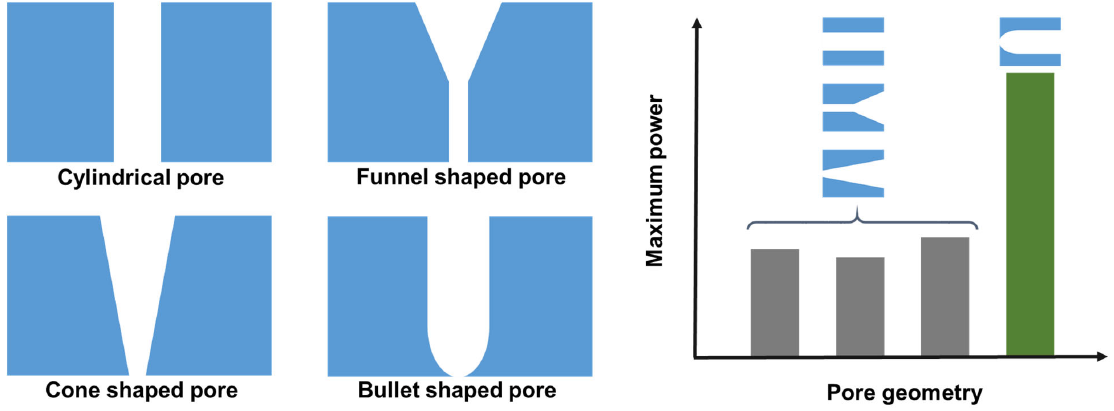
Figure 3. Schematic representation of different pore geometries in track ‐ etched membranes. The bullet ‐ shaped pore generates higher power compared to the pores of other geometries.